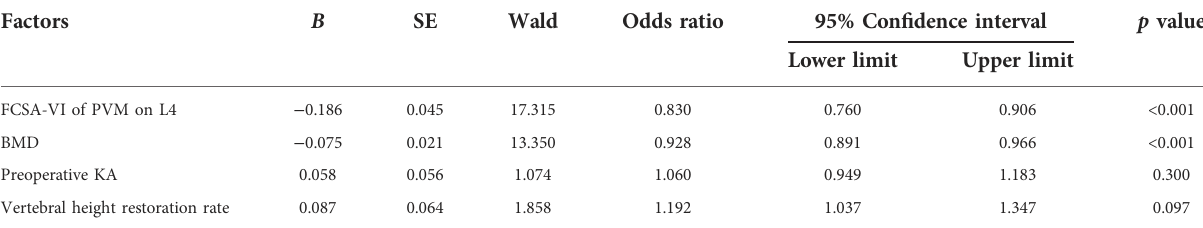
TABLE 7 Logistic regression analysis. Factors